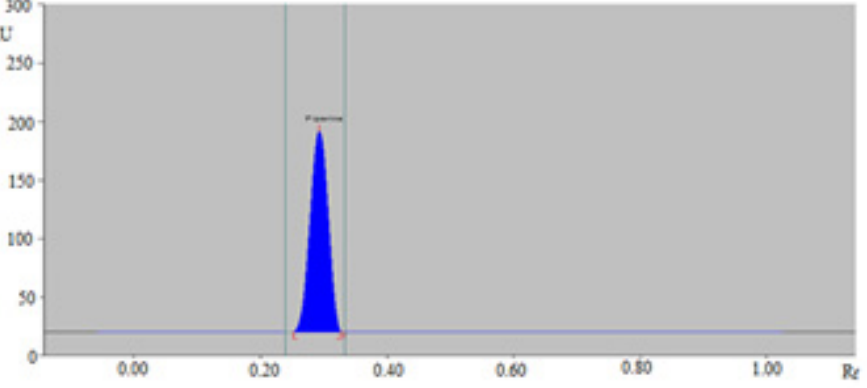
Figure 2. Densitometry chromatograms of standard PPN recorded using normal-phase HPTLC. For a reversed-phase HPTLC analysis of PPN, the different proportions of ethanol and v / v ), ethanol/water (70:30, v / v ), and ethanol/water (80:20 v / v ) were studied as the